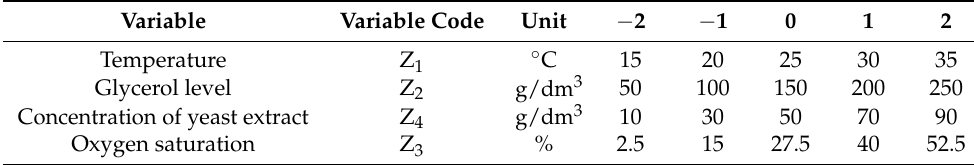
Table 4. Values of the independent variables used for the